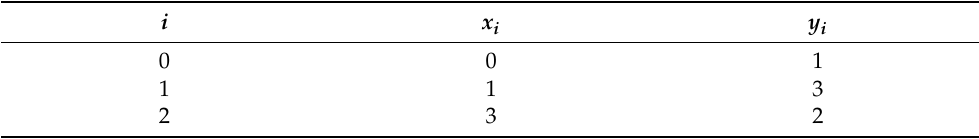
Table 1. Numerical example for interpolating a parabola.